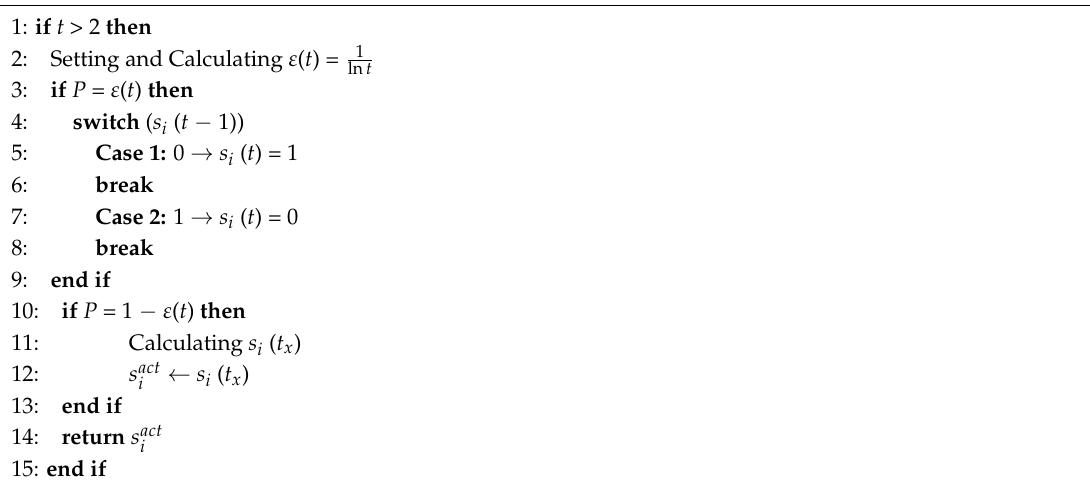
Algorithm 2. DCGA for every node in the network in game execution